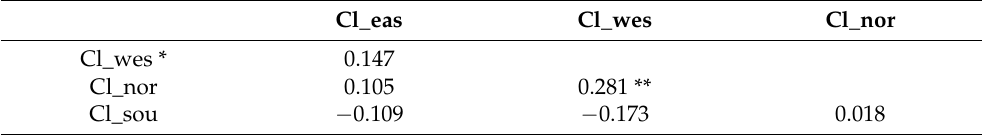
Table 3. Correlation matrix for Cl in pine #1. Cl_eas Cl_wes Cl_nor Cl_wes * 0.147 Cl_nor 0.105 0.281 ** Cl_sou − 0.109 − 0.173 0.018 * wes = west, nor = north, sou = south, eas = east. ** significant at p < 0.05, other values are insignifi- cant.